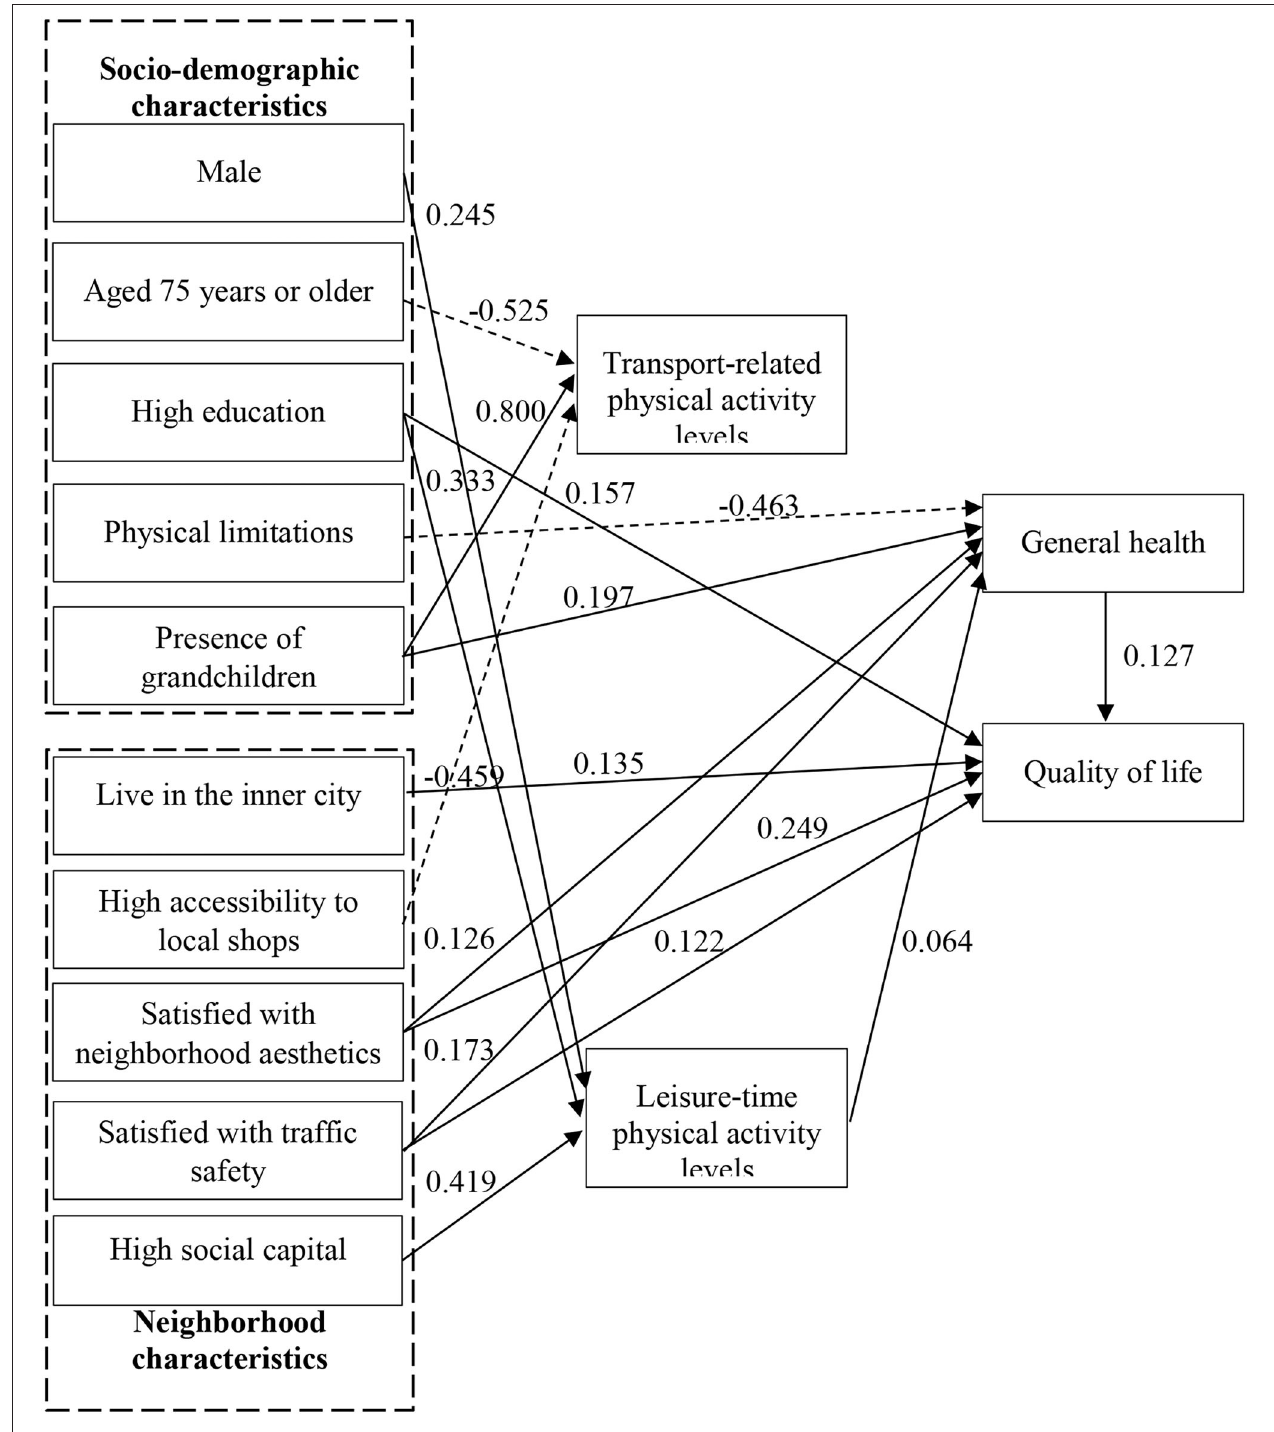
FIGURE 2 | Significant direct